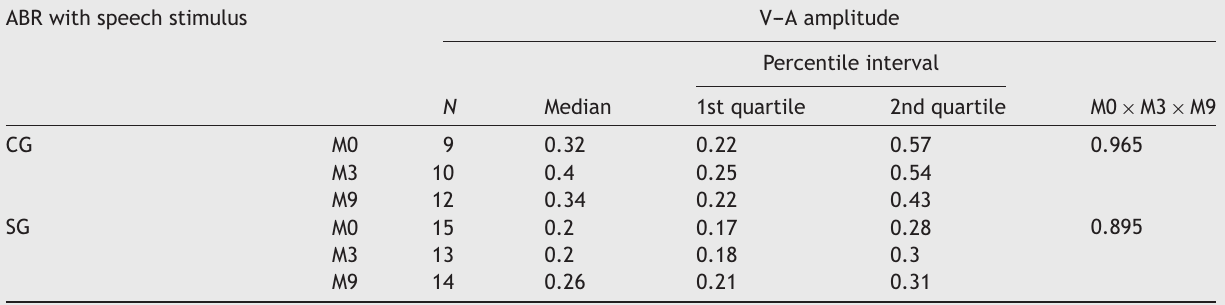
Comparison of the V---A amplitude of ABR with speech stimulus, at moments 0, 3, 9 months, in the control (CG) and study (SG) groups.